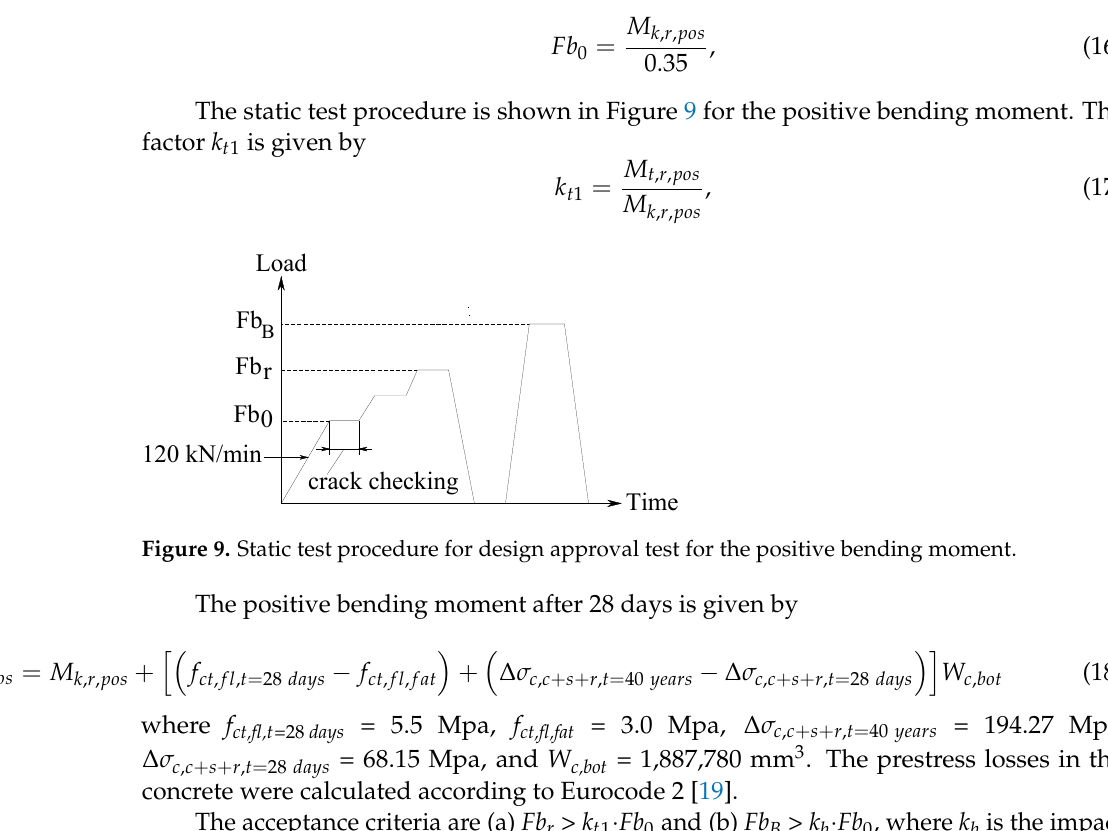
Figure 9. Static test procedure for design approval test for the positive bending moment.